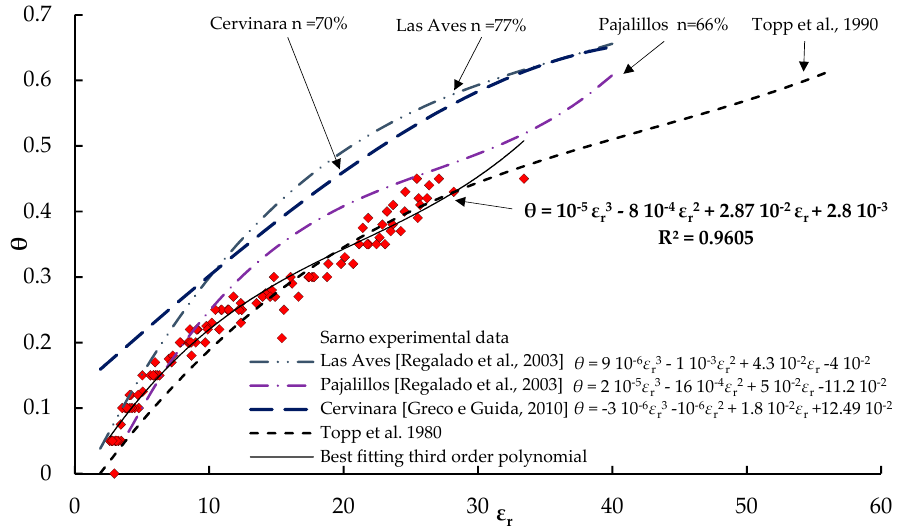
Figure 3. Experimental data of soil volumetric water content and relative dielectric permittivity compared with some empirical calibration curves from the literature. The best fitting third order polynomial of the experimental data is also plotted. Table 2. Experimental data of soil volumetric water content and dielectric permittivity of the three investigated soils for the different tested porosities.